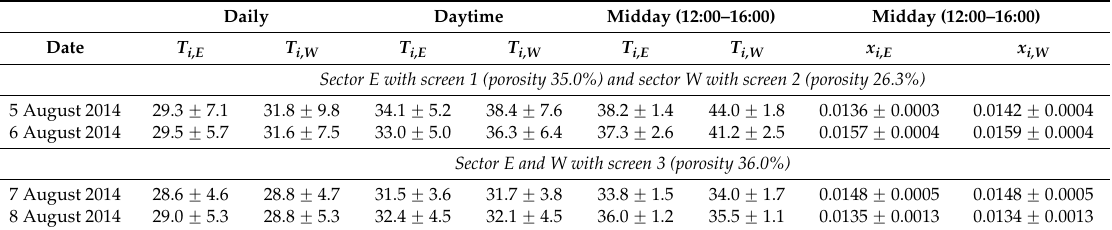
Figure 6. Air temperature (°C) ( a ) and inside-outside air temperature difference ∆ T io (°C) ( b ) on the days of the experiment. Outside ( ― ); mean values of all the sensors in sector E with screen 1 ( ― ), sector W with screen 2 ( ― ), sector E with screen 3 ( - - - ) and sector W with screen 3 ( - - - ). Table 5. Air temperature T i (°C) and absolute humidity x i (g·g − 1 ) inside the greenhouse (average value ± standard deviation) and inside-outside temperature ∆ T io (°C) and absolute humidity ∆ x io (g·g − 1 ). Subscripts: E sector east and W sector west. Midday (12:00–16:00)